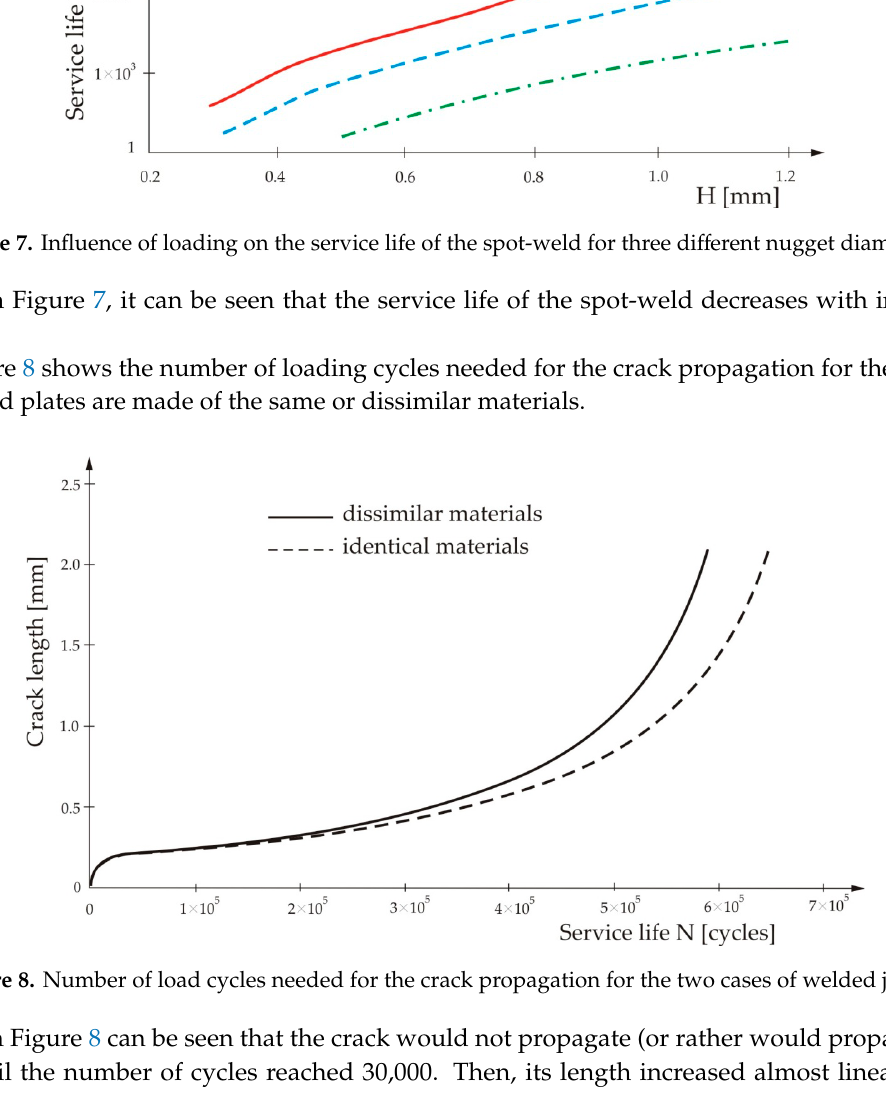
Figure 6. Influence of Thin Sheet 2’s thickness on the service life of the spot-weld for three different nugget diameters.